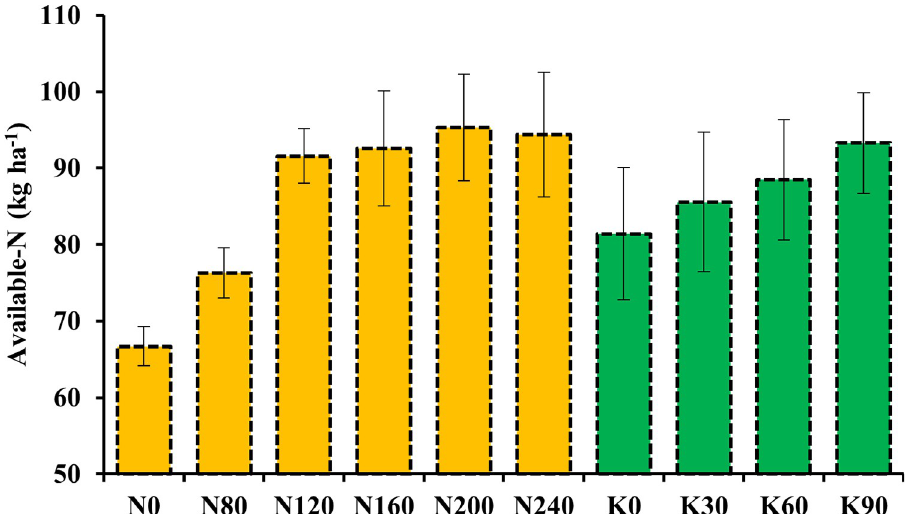
Fig 7. Effect of nitrogen (N) and potassium (K) application on available-N content in a sandy loam soil in sub- tropical India. Bars indicate the standard error from mean (S . E . M )